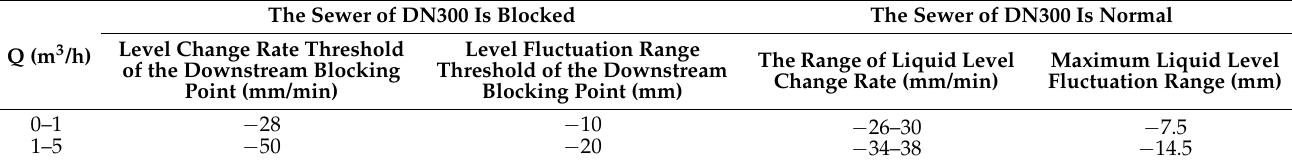
Table 6. Sewer blockage identification matrix of